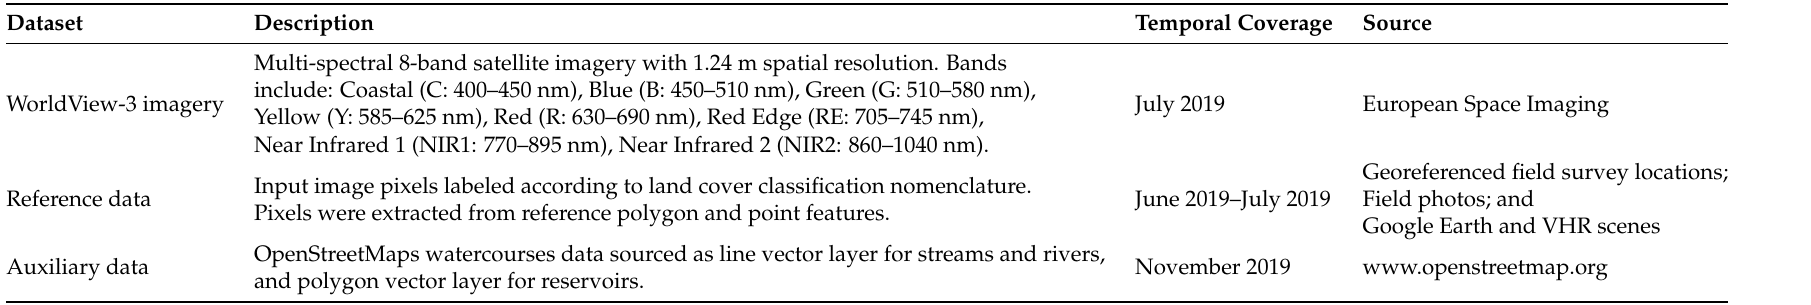
Table 2. Description of datasets